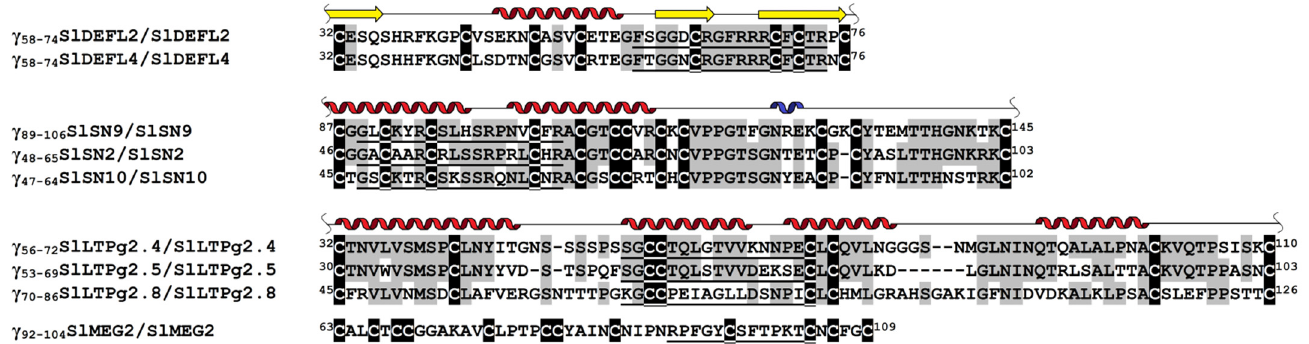
Figure 1. Multiple sequence alignment of the γ -core-containing regions of selected tomato CRPs. Superscript numbers denote their position in the precursor proteins. The sequences of synthesized peptides are underlined. The names of synthetic peptides and their parent CRPs are shown on the left. Cysteine residues are shaded black, and identical amino acids are shaded gray. Secondary structure elements ( α - and 3 10 -helices, and β -strands) are shown above the corresponding sequences as helices ( α -helix is shown in red, and 3 10 -helix is colored blue) and arrows, respectively. In snakins, the secondary structure was predicted by Porto and Franco [17].